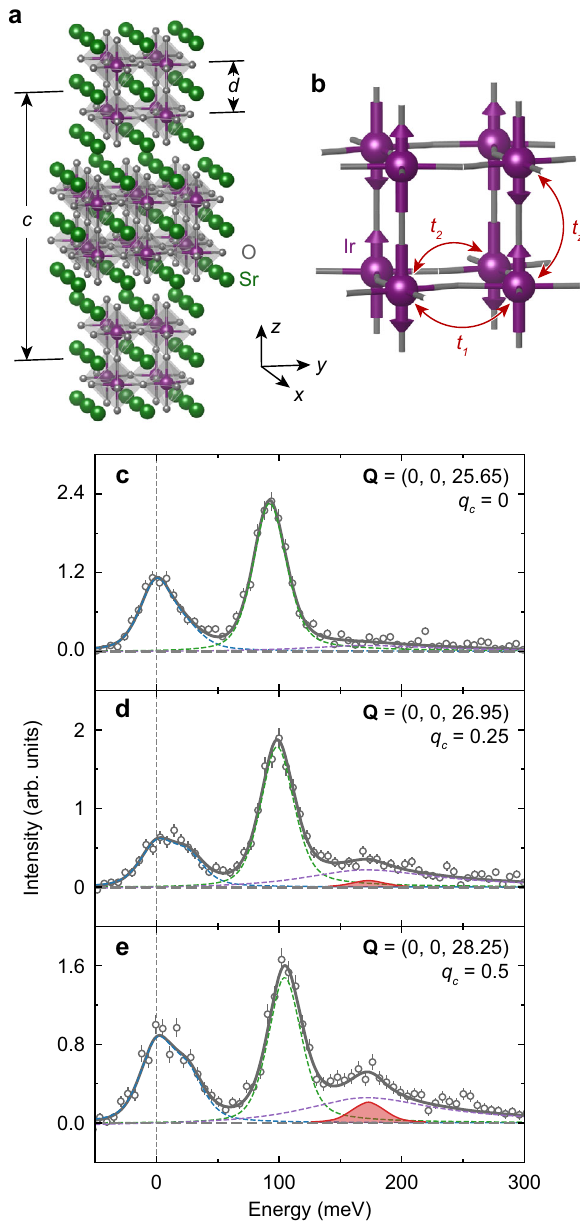
Fig. 2 Isolating the excitonic longitudinal mode in Sr 3 Ir 2 O 7 . a Crystal structure of the bilayer material Sr 3 Ir 2 O 7 . b Ir-Ir bilayer with t 1 the nearest- neighbor, t 2 the next-nearest-neighbor and t z ( α ) the interlayer hopping terms. c – e RIXS spectra measured at T = 20 K and Q = (0, 0, L ) with L = 25.65, 26.95 and 28.25 in reciprocal lattice units. The c -axis positions are also labeled in terms of the Ir-Ir interlayer reciprocal-lattice spacing q = 0, 0.25 and 0.5. An additional mode appears around 170 meV with c maximal intensity at q c = 0.5 (see shaded red area). The black circles represent the data and dotted lines outline the different components of the spectrum, which are summed to produce the grey line representing the total spectrum. Error bars are determined via Poissonian